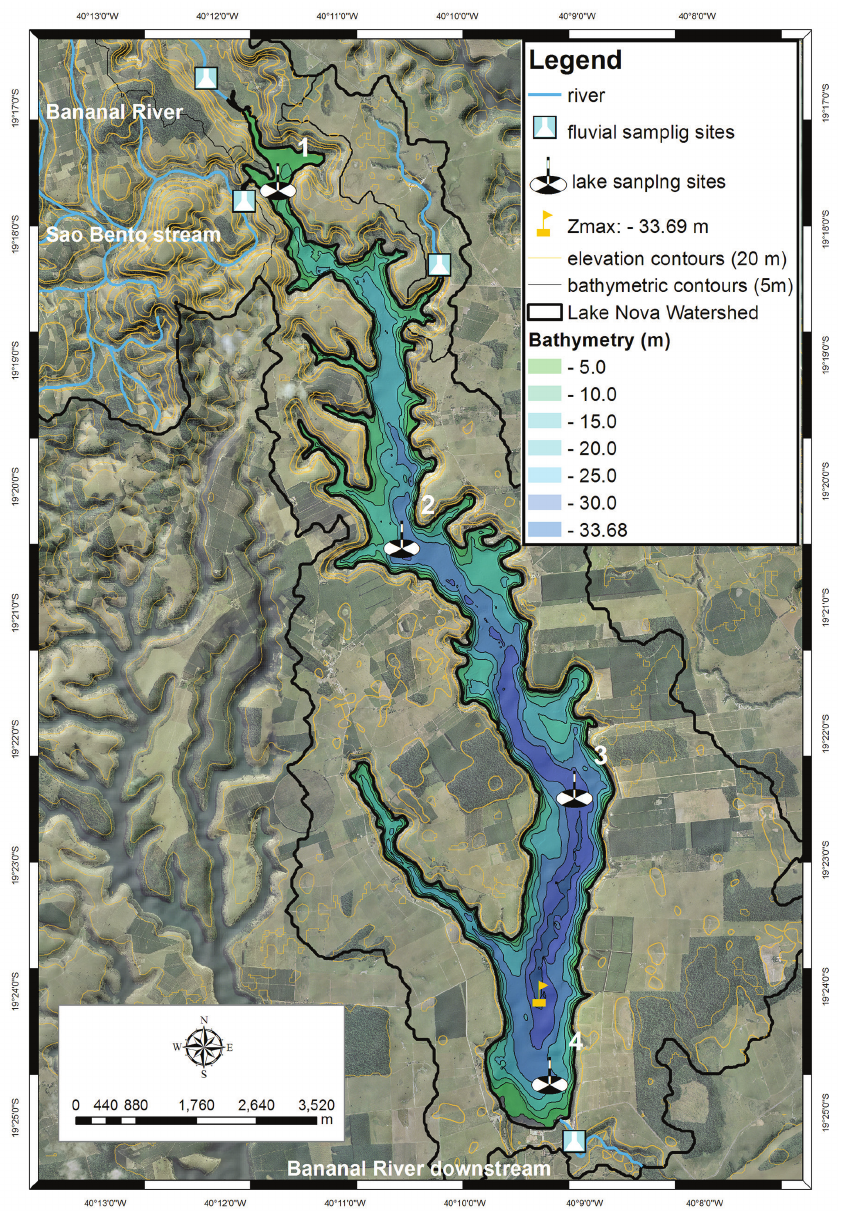
Figure 3 - Bathymetric map of Lake Nova draped on an aerial photography and showing lake and fluvial sampling sites.